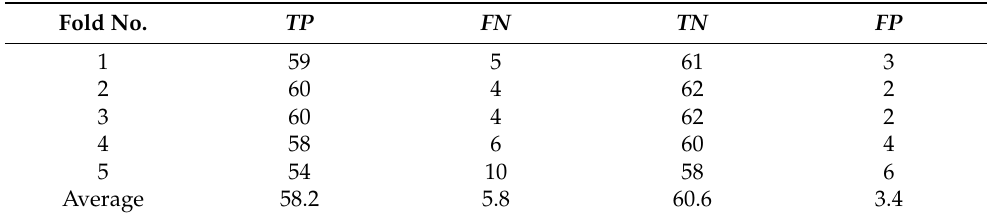
Table 2. Test results of bathroom fall experiments.